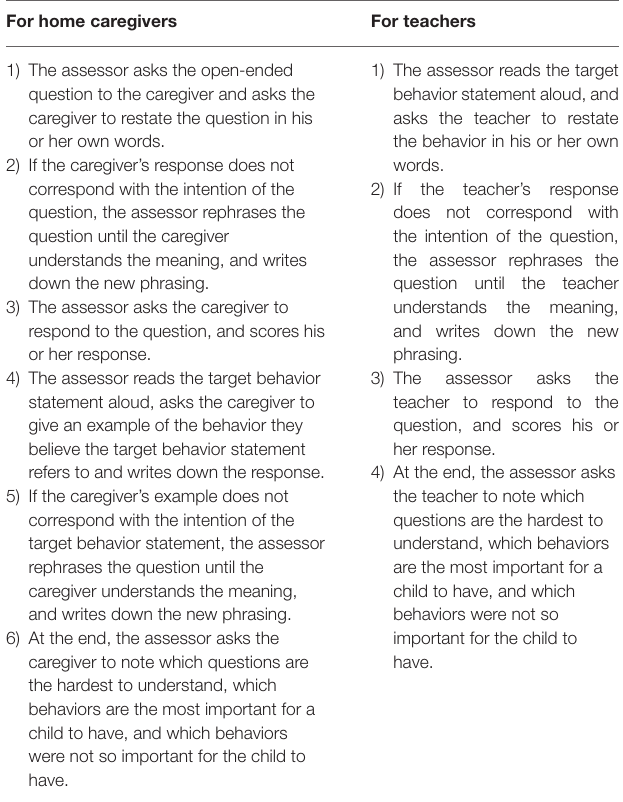
TABLE 3 | Initial tool piloting